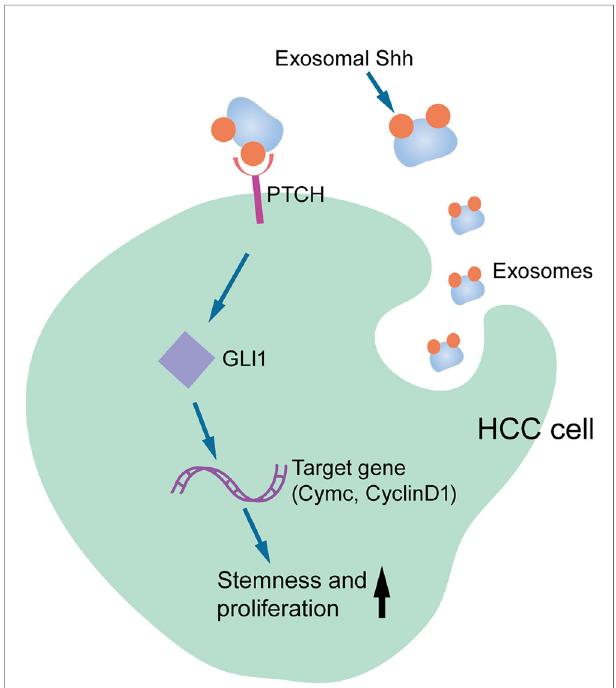
FIGURE 7 | Diagram for the Exo-Shhactivating Hedgehogsignaling inHCC